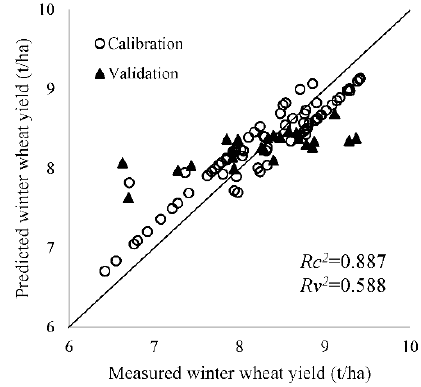
Figure 9. Calibration and validation of winter wheat yield prediction based on the weighted full-spectrum information.